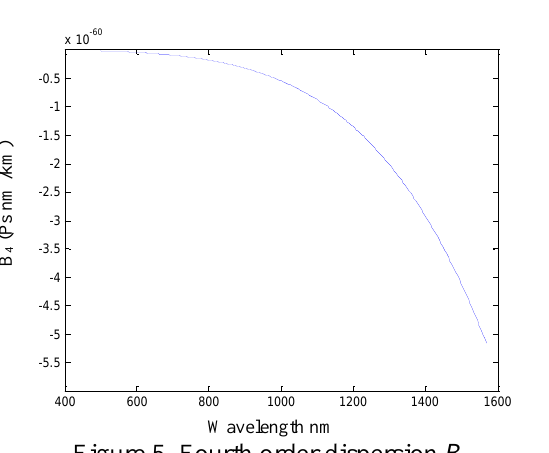
Figure 3. Group-velocity dispersion B